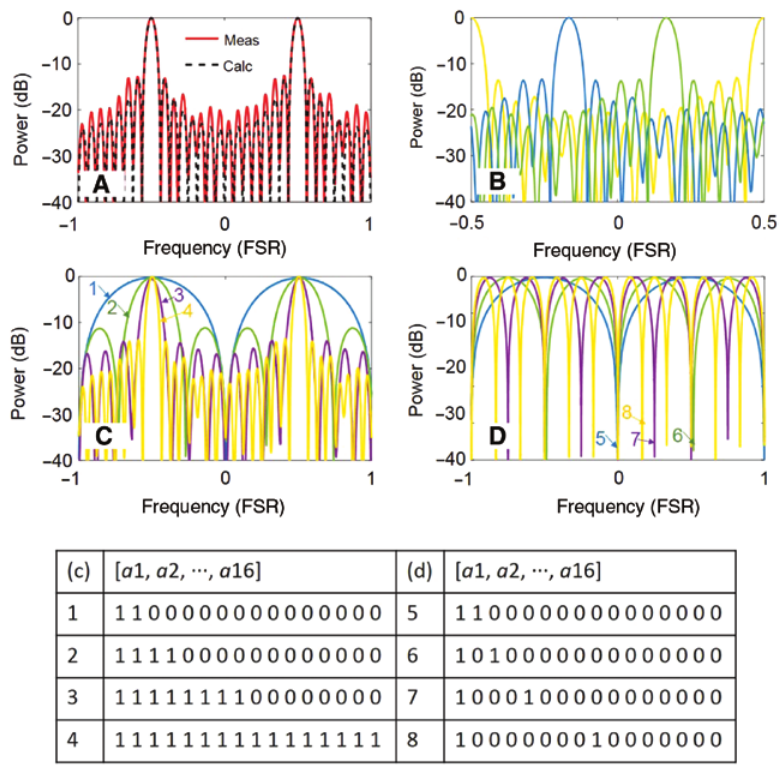
Figure 4: Filter frequency response measurements: (A) comparison between measurement and calculation; (B‒D) demonstrations of pass- band frequency shifting, passband shaping and variation of filter’s free spectral range (inset table: filter